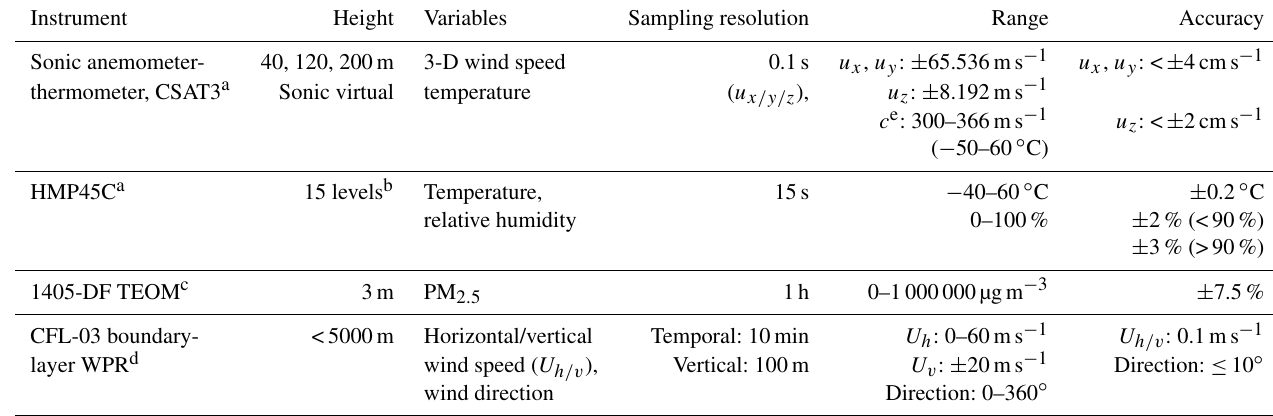
Table 1. Performance characteristics of instruments.